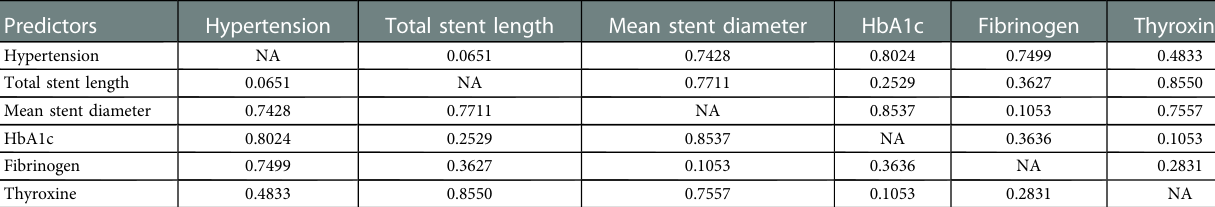
TABLE 3 Interaction analysis of